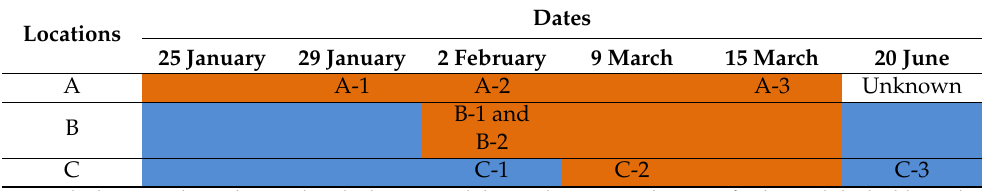
Table 4. Sediment transport time